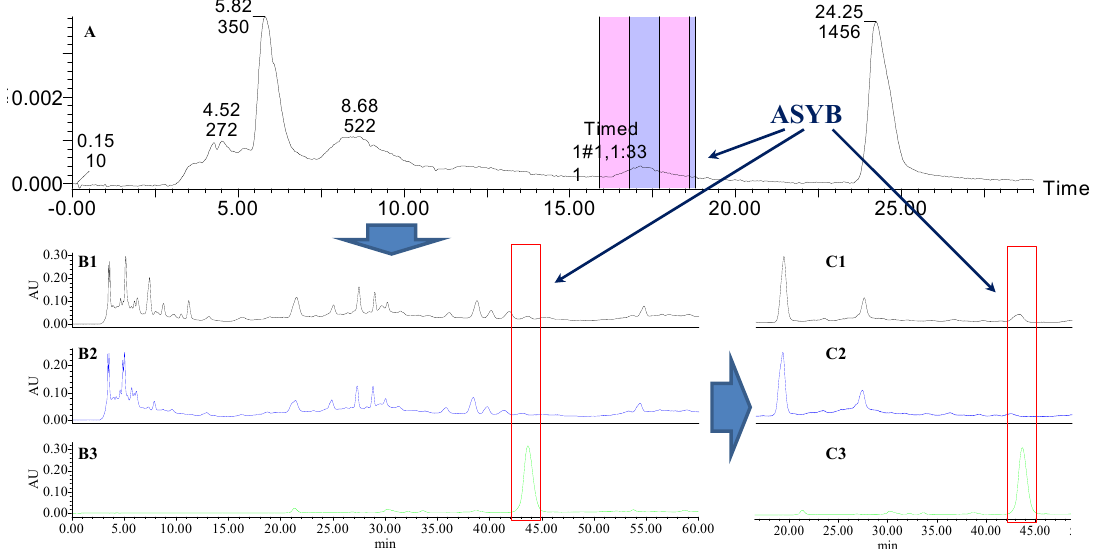
Figure 16. The preparative and analytical chromatograms of the depletion of ASYB from CF-GR. ( A ) preparative chromatogram at 270 nm; ( B1 ) analytical chromatogram of CF-GR at 270 nm; ( B2 ) analytical chromatogram of CF-GR-B at 270 nm; ( B3 ) analytical chromatogram of ASYB depleted from CF-GR at 270 nm. ( C1 ) analytical chromatogram of CF-GR at 400 nm; ( C2 ) analytical chromatogram of CF-GR-B at 400 nm; ( C3 ) analytical chromatogram of ASYB depleted from CF-GR at 400 nm.